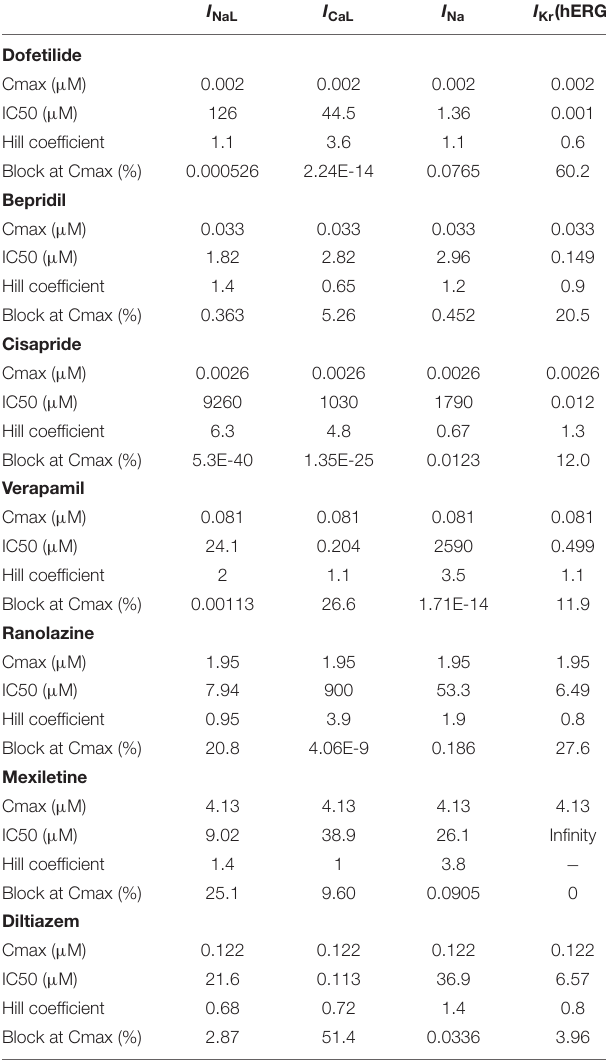
TABLE 2 | Percentages of blockage of four ionic